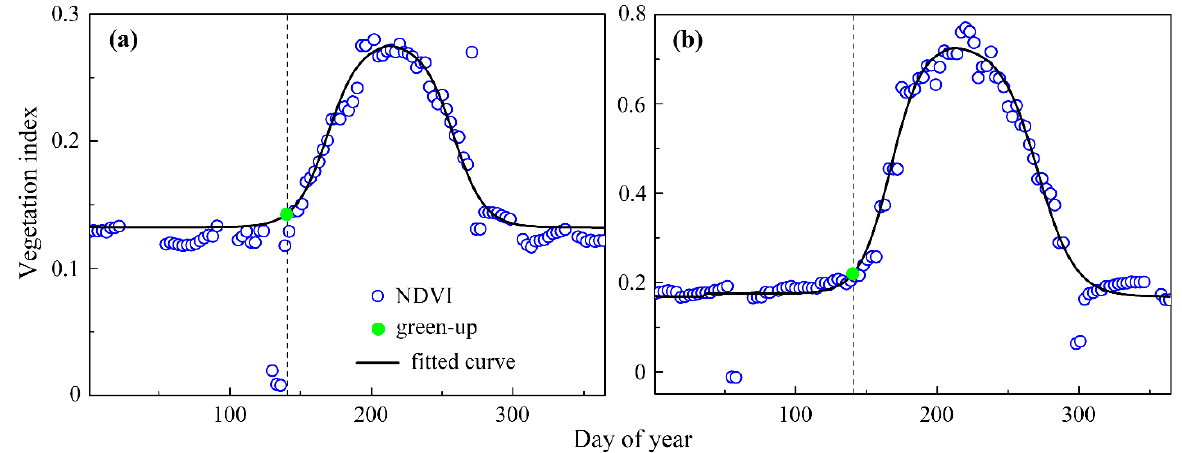
Figure 2. MODIS NDVI curve fitting and green-up onset estimation. ( a ) is a sample pixel in steppe area and ( b ) is a sample pixel in meadow area in the QTP. The light green dot denotes the green-up onset point of alpine grassland on the fitting curves and the corresponding horizontal axis coordinate is the green-up onset.